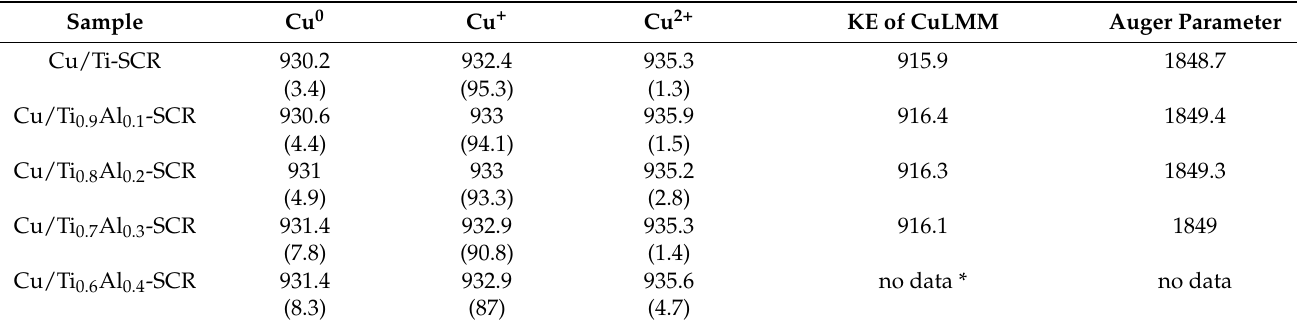
Table 6. Spectral fitting parameters for Cu 2p 3/2 lines of used catalysts: binding energy (eV) and percentage of total area (in parentheses). The kinetic energy of CuLMM (eV) and Auger parameter (eV) are also listed.